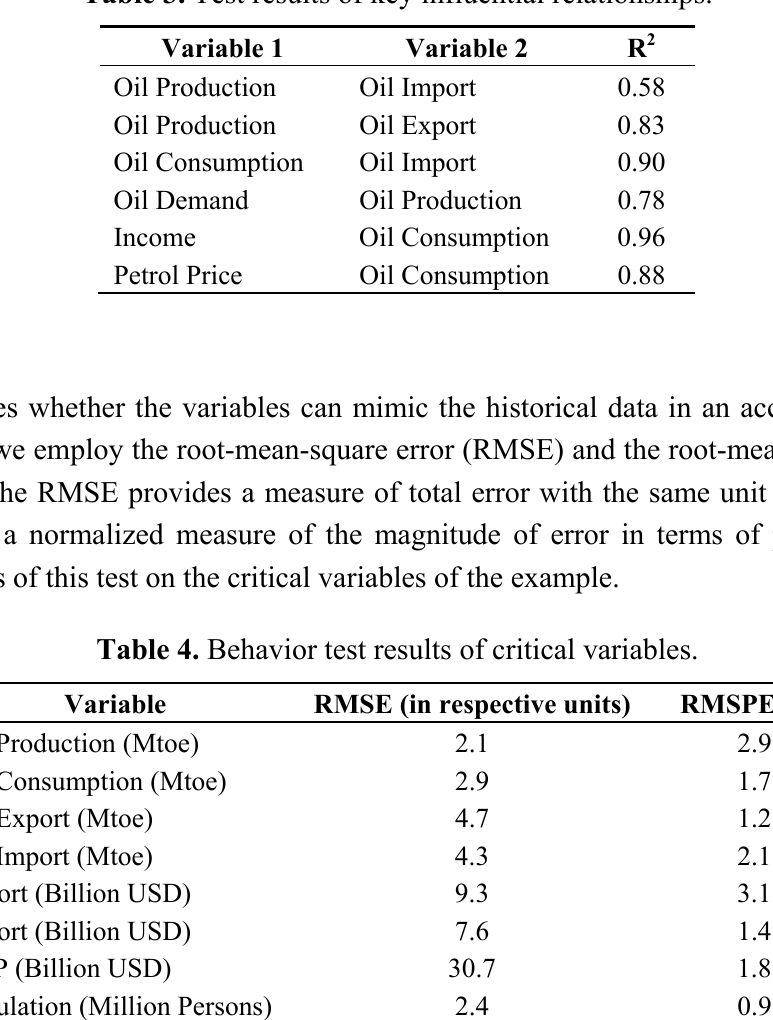
Table 3. Test results of key influential relationships.